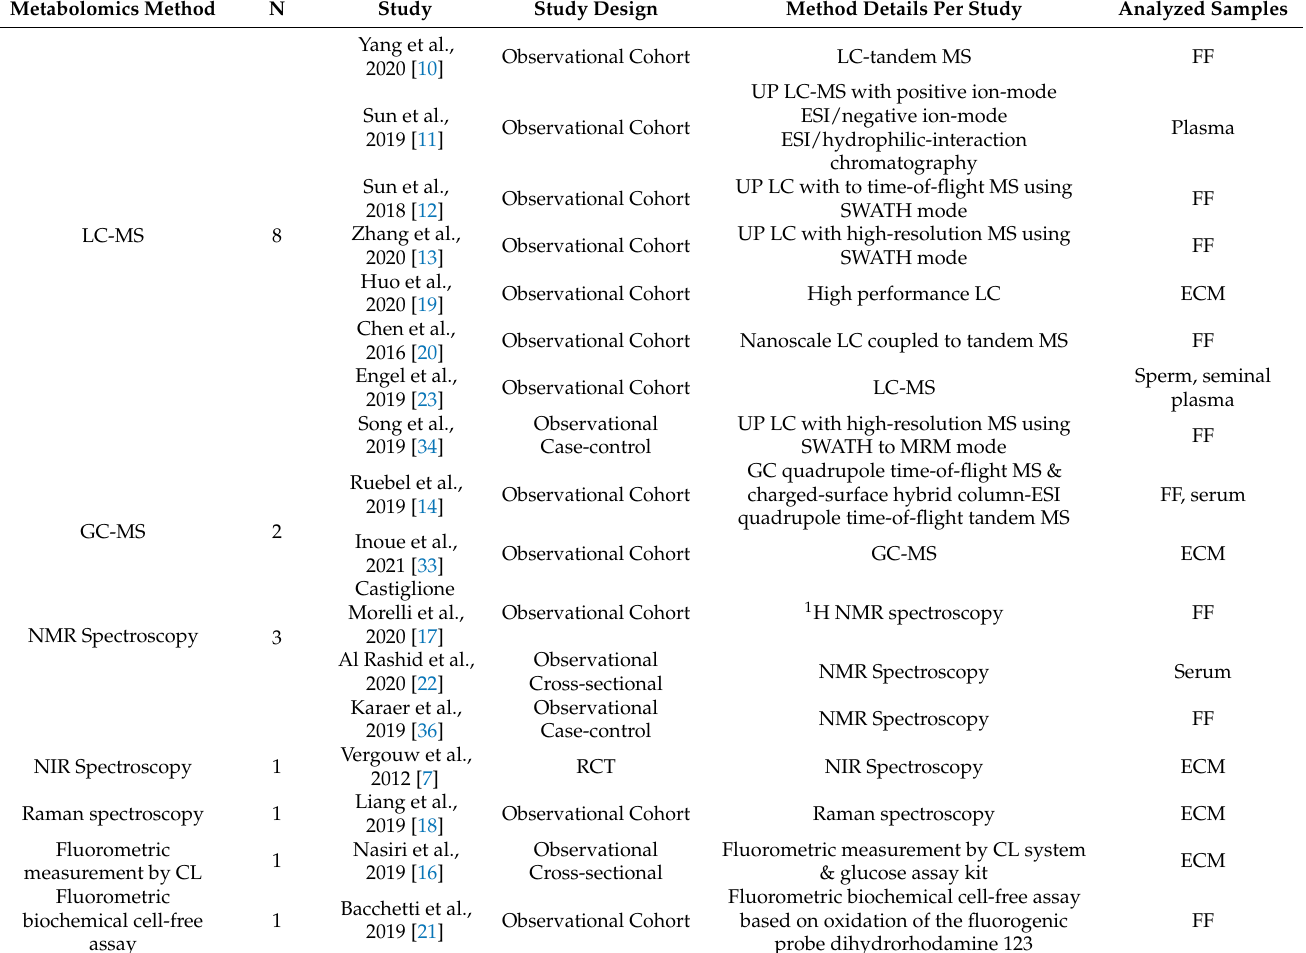
Table 1. Demonstrates variability between methods used for metabolomics analysis of human samples. All studies included in table are original studies with human